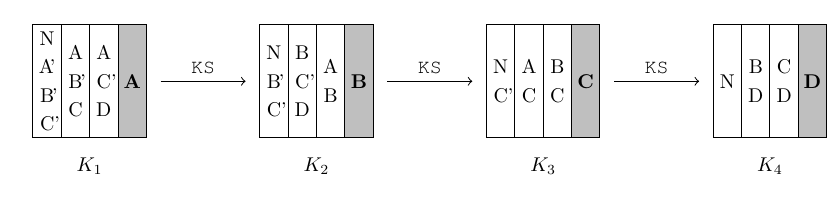
Figure 11: 4-round difference propagation of AES-128 key schedule.